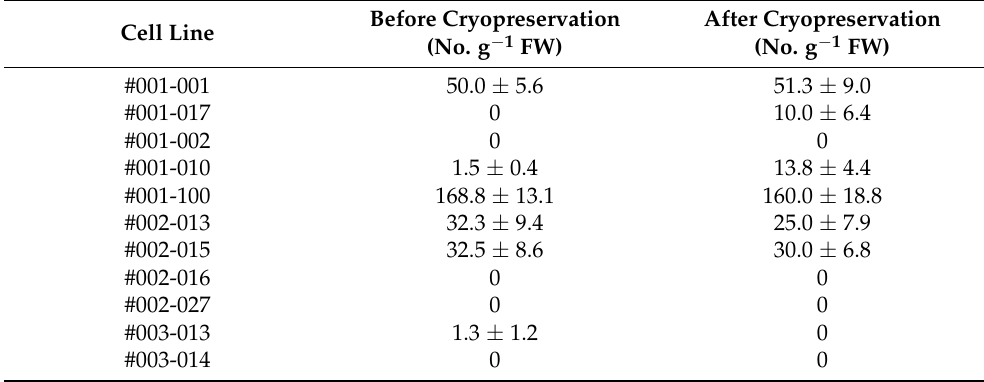
Table 9. Effect of cryopreservation on maturation of Korean pine somatic